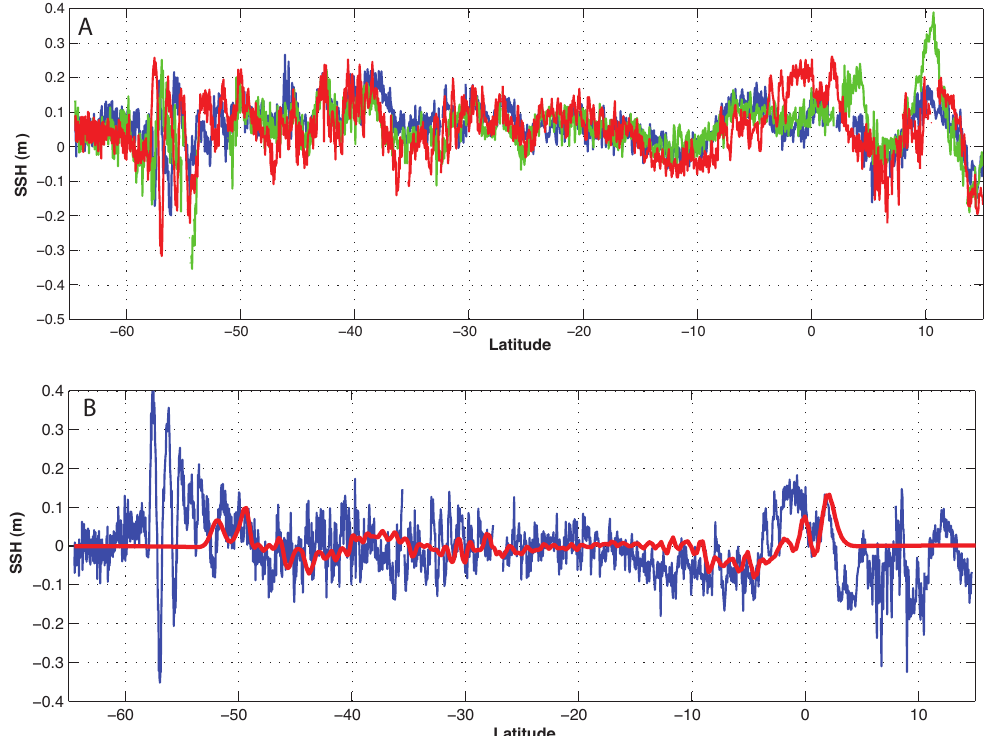
Fig. 7. (A) SSH data for pass 15 of Jason-2 cycles 60 (blue), 61 (red – tsunami) and 62 (green). (B) Filtered SSH data (blue) for pass 15 of cycle 61 with MOST model results (red)